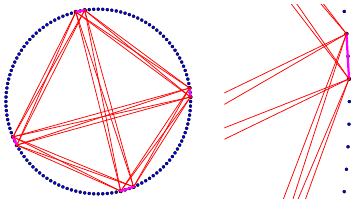
Figure 5: An illustration of the 1RSB Ansatz with n = 8 replicas and group size m = 2, and for the case of a circular model (compare with fig. 1). The red (green) lines represent Wick contractions between replicas of different (same) group, called inter-group (intra-group, respectively) interactions in the text. The right figure is merely a zoom of the left one into the UV